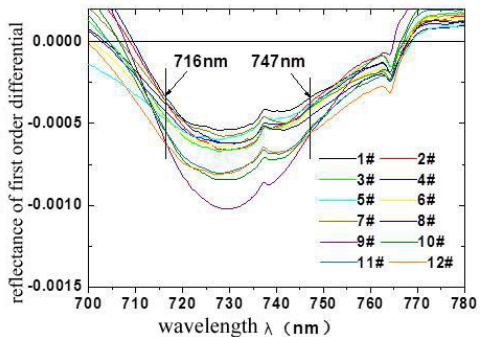
Figure 6. reflectance of first order differential amplifier in 704-753nm